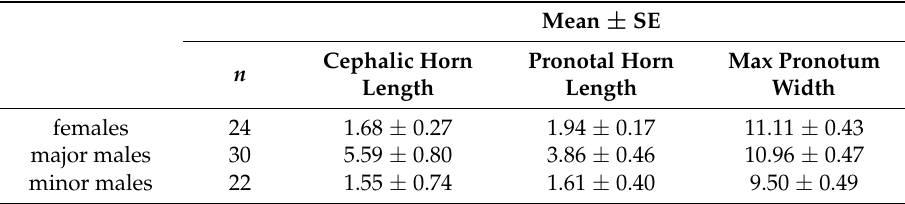
Table 1. Descriptive statistics of the cephalic and pronotal horn length, and pronotum width (body size). Measures were taken in